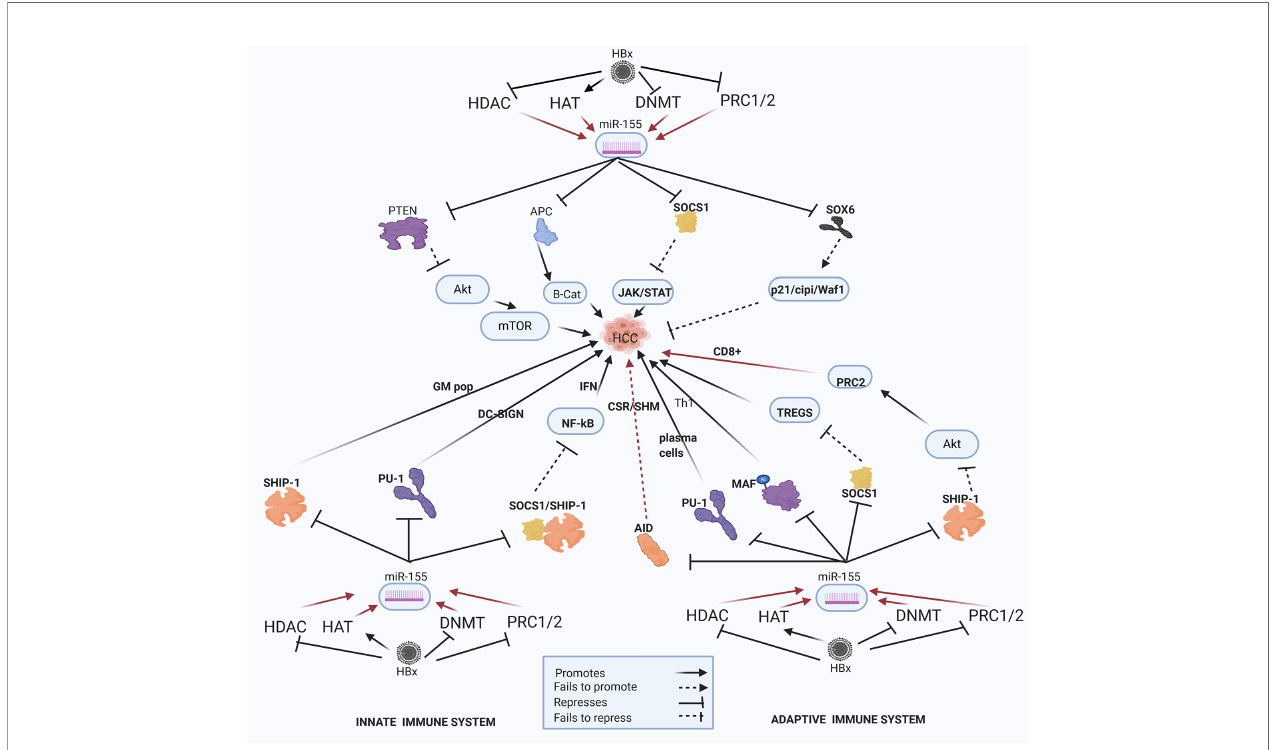
FIGURE 5 | Epi-miR-155 and HBV-HCC and immune pathways. HDAC-Histone deacetylation, HAT-histone acetylation, DNMT-DNA methylation, PRC1/2- Polycomb Repressive Complex 1 and 2 (pathways in dark red involve identi fi ed direct upstream or downstream epigenetic proteins/enzymes). HMT-Histone methylation. HBx protein can downregulate or initiate HDAC/HAT/DNMT/HMT to upregulate miR-155 modulation in various HBV-HCC pathways including AKT/ MTOR, TP53, and JAK/STAT to in fl uence HCC pathogenesis. HBx epigenetically upregulated miR-155 also regulates germinal matrix (GM) population and NF-kB expression in the innate immune system, as well as T-cell and B-cell expression in the adaptive immune